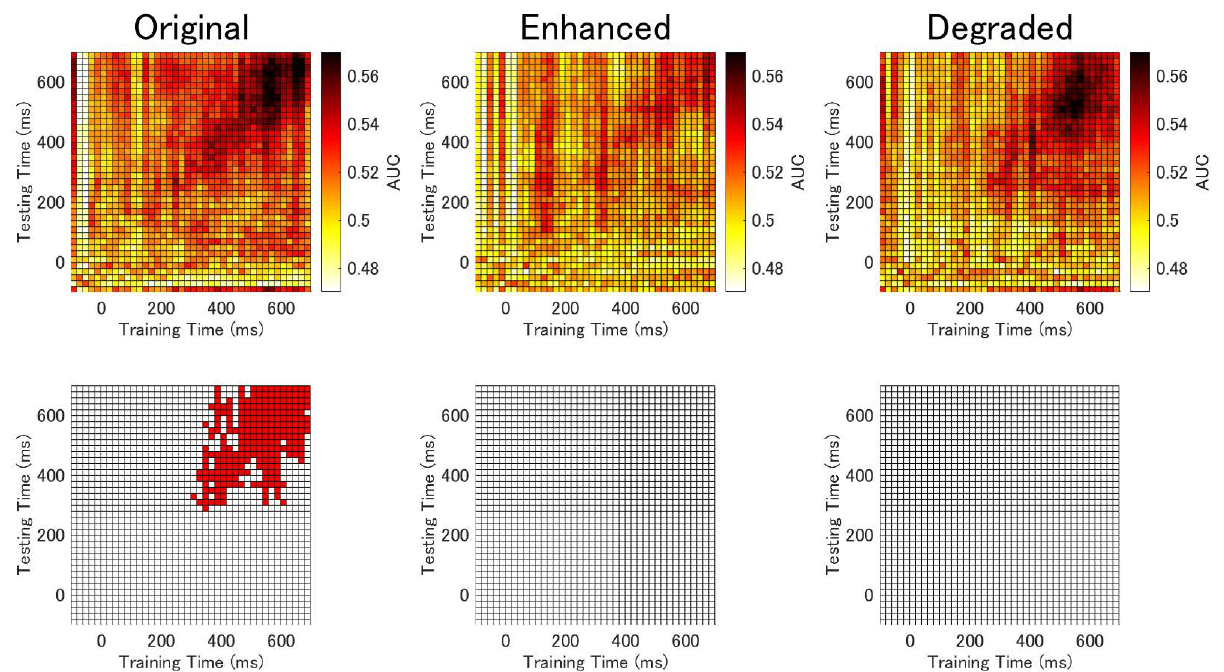
Figure 8. Temporal generalization matrix for classification of self and other familiar faces in each condition. In the upper panes, colour represents the values of AUC. The significant cluster is described in red in the lower panels.